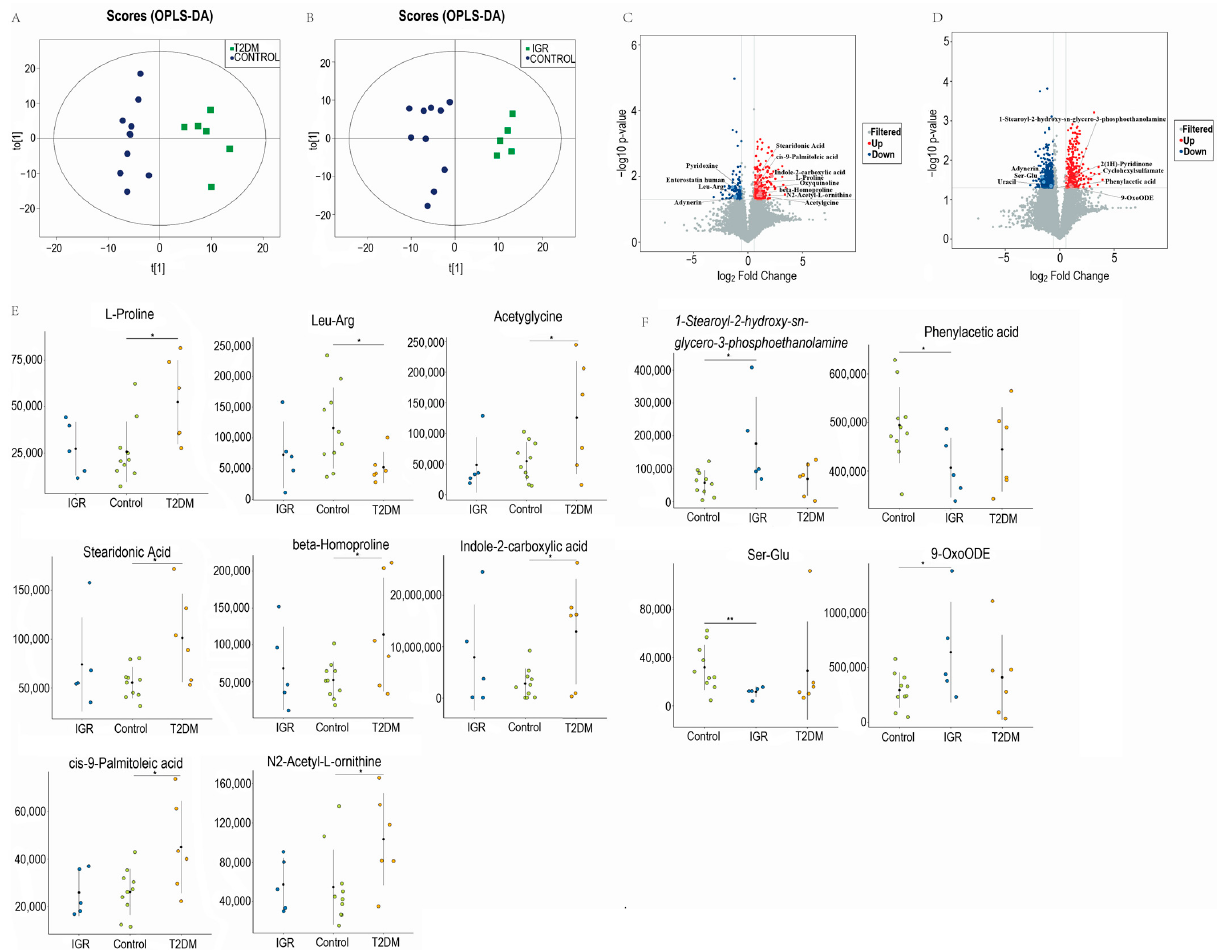
Figure 3. Orthogonal projection to latent structures discrimination analysis (OPLS-DA) score plots between T2DM and Control groups ( A ), IGR and Control groups ( B ) in positive model. Volcano plots of metabolomics between T2DM and Control groups( C ), IGR and Control groups ( D ). Significantly differentially upregulated candidates (Fold change ≥ 1.5, p < 0.05) are plotted in red, and significantly differentially down-regulated candidates (Fold change ≥ 1.5, p < 0.05) are plotted in green. Enrichment analysis of the differentially abundant pathways between T2DM and Control groups ( E ), IGR and Control groups ( F ). * p < 0.05 and ** p < 0.01.